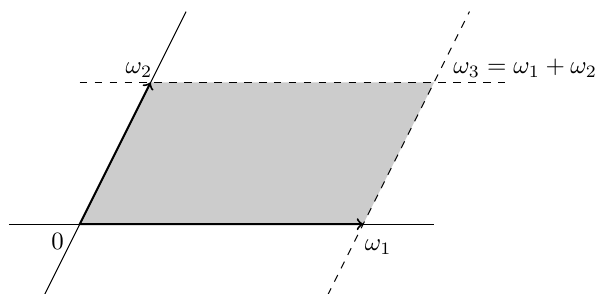
Figure 1 . The lattice (cid:3) spanned by the two periods ! fundamental